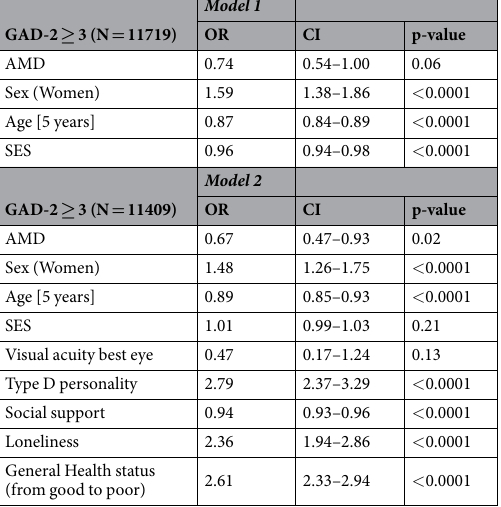
Table 5. Associations (multivariate logistic regression analysis) of AMD with generalized anxiety in the Gutenberg Health Study (GHS) and significantly associated parameters. Abbreviations: CI (95% confidence Interval), GAD-2 (Generalized Anxiety Disorder Scale), OR (Odds ratio), SES (socioeconomic status). GAD-2 ≥ 3 defined as caseness for generalized anxiety. Model 1: Logistic regression analysis adjusted for age, sex, socio-economic status. Model 2 * : Additionally, adjusted for systemic comorbidities, self-reported ocular diseases, visual acuity of the best eye, mental health (Type D personality, loneliness, social support) and general health status. * not significantly associated parameters (systemic comorbidities, ocular diseases) are not presented in this table. Model 2 with full list of covariates can be found in the Supplementary Table S2.